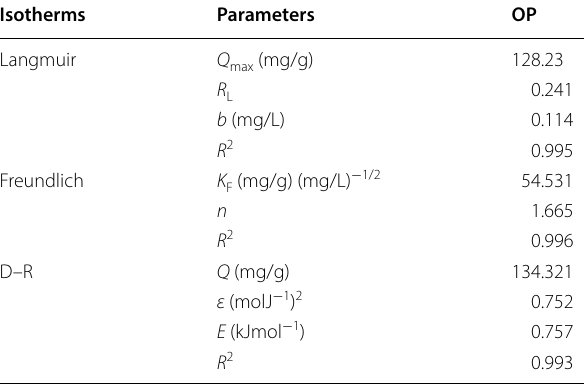
Table 2 Isotherm parameters of cadmium adsorption on OP